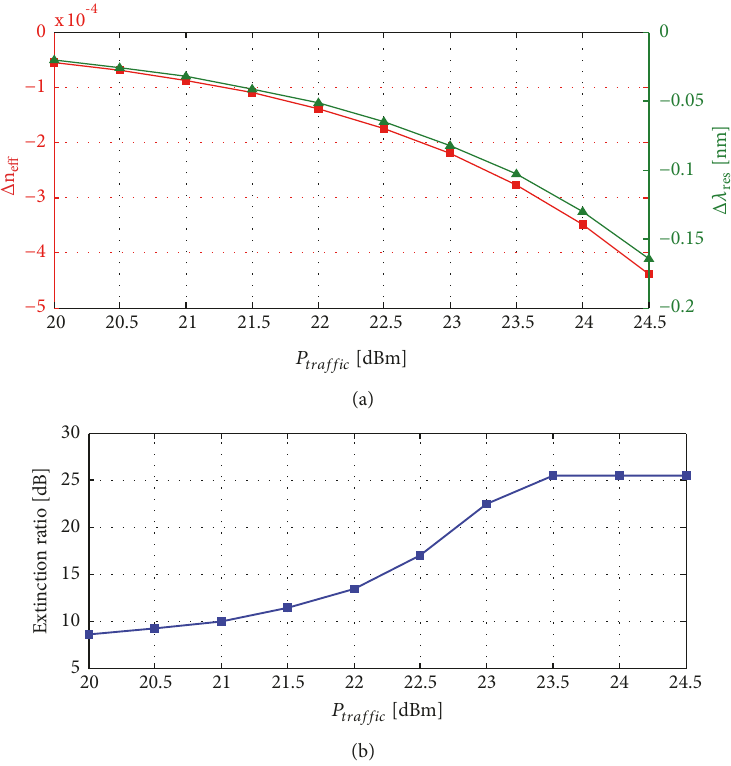
Figure 9: (a) (cid:2) n eff (squares) and Δ𝜆 res (triangles); (b) extinction Ratio (ER) as a function of the traffic signal